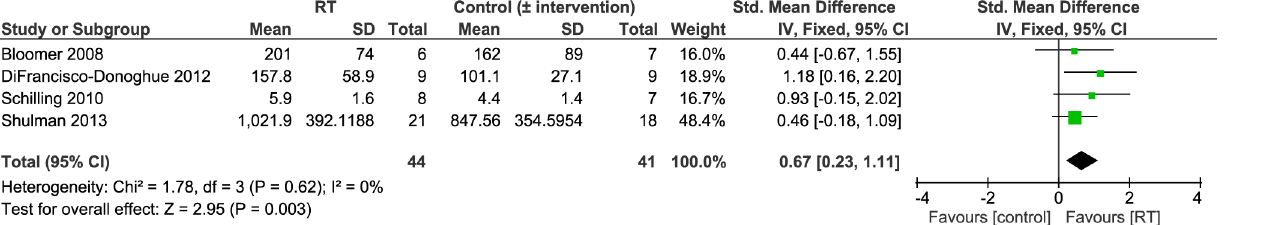
PLOS ONE | DOI:10.1371/journal.pone.0132135 July 6,